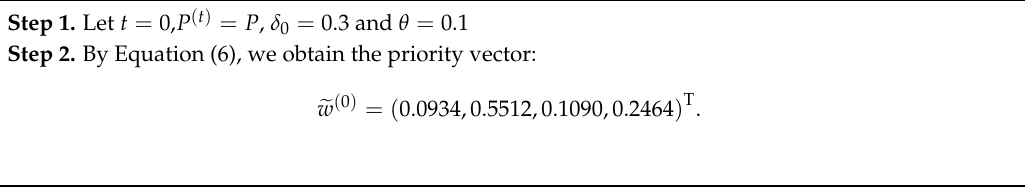
Algorithm 3: The consistency adjusting process of HMPR based on logarithm least squares